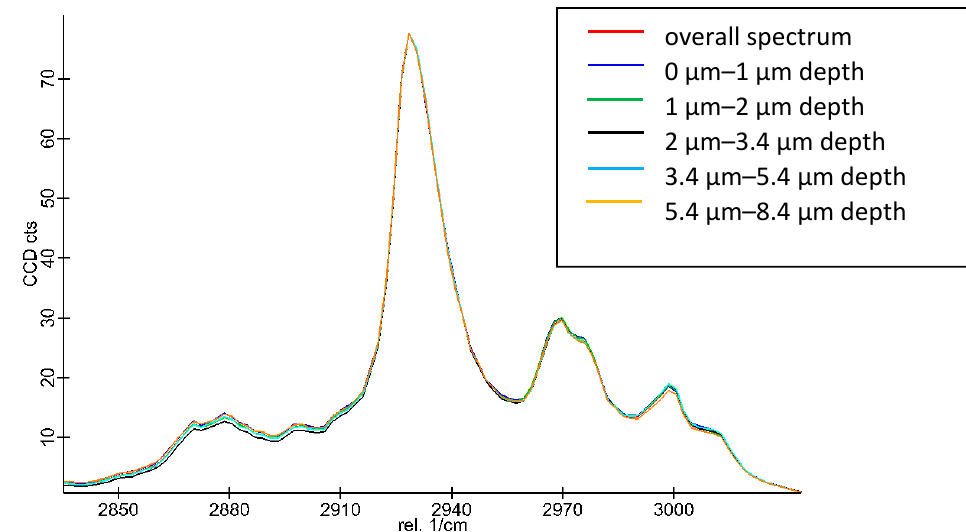
Figure 12. Raman spectra of samples .